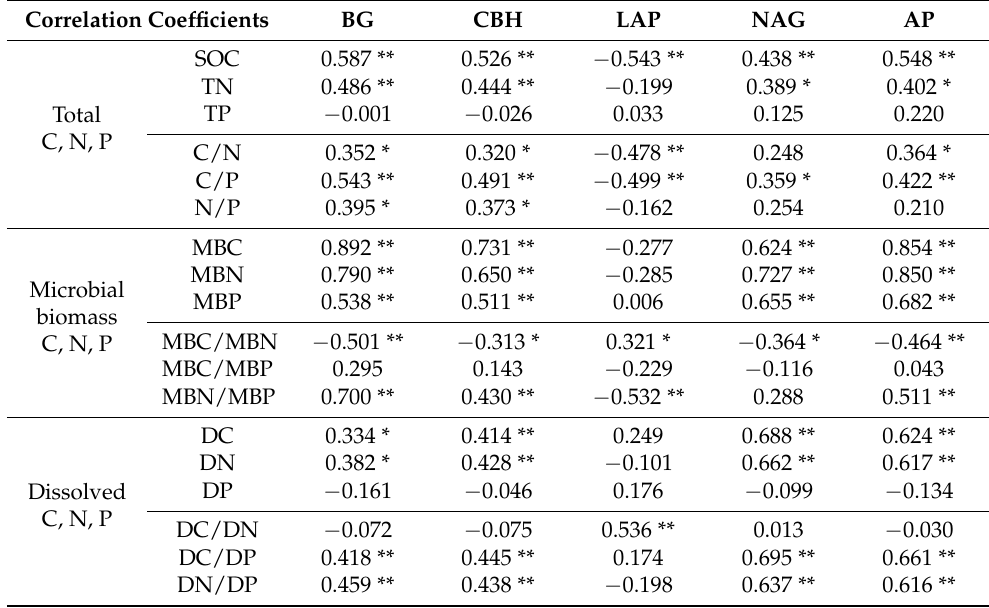
Table 1. Pearson correlation coefficients between soil C, N and P fractions variables and enzyme activities.